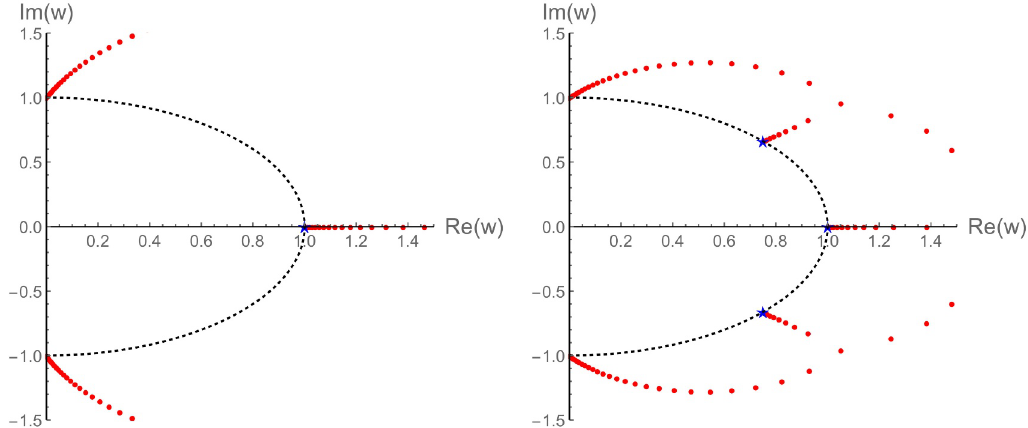
Figure 6 . Poles of the Padé approximant P ( w ) for t = 1 / 2 (left) and t = 3 (right) for Gaussian initial data with s = 1 . The blue stars signal the images of z the dashed black line corresponds to the | w | = 1